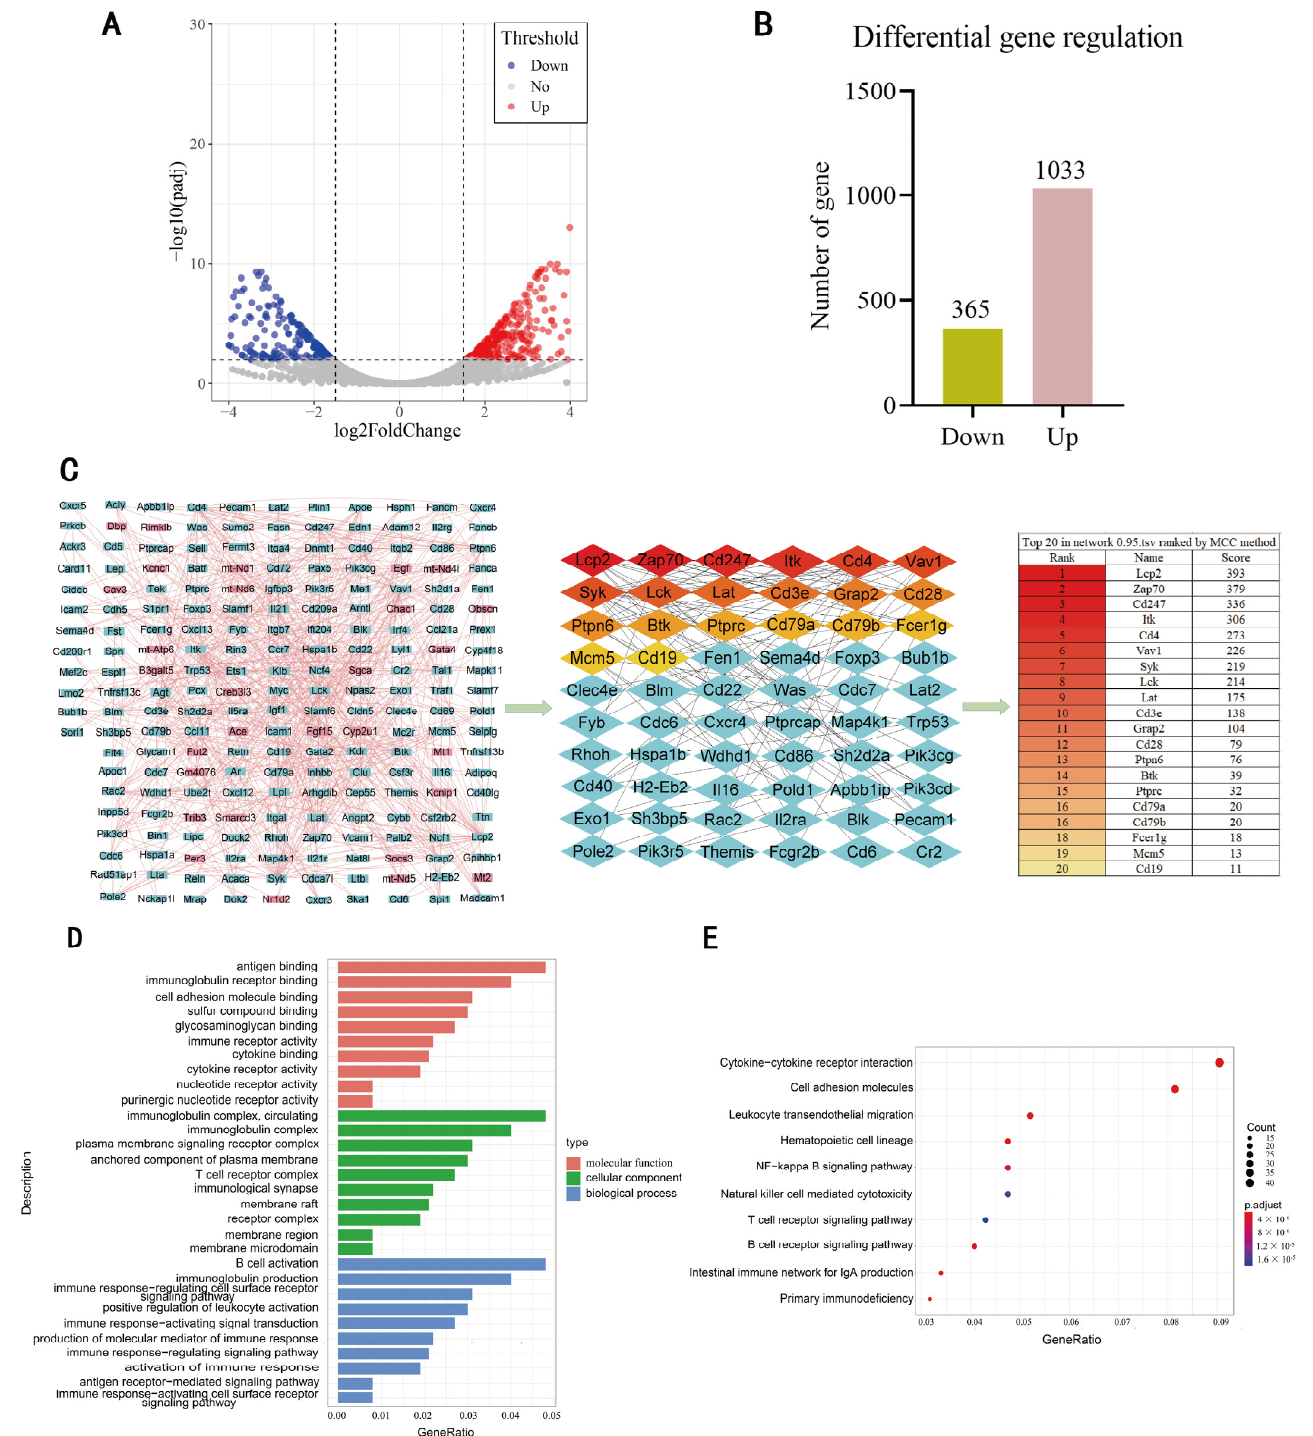
Figure 2. Screening of DEgenes based on RNA-Seq. ( A ) Volcano plot of differential miRNAs with |log (fold change)| ≥ 1.5, p ≤ 0.01 as screening criteria. ( B ) Distribution of upregulated and downregulated DEgenes. ( C ) The interaction network between DEgenes generated using the STRING online tool and visualized with Cytoscape 3.9.0, in which the core genes were identified using Cytohubba plugin. ( D ) GO enrichment of DEgenes. ( E ) KEGG enrichment of DEgenes.